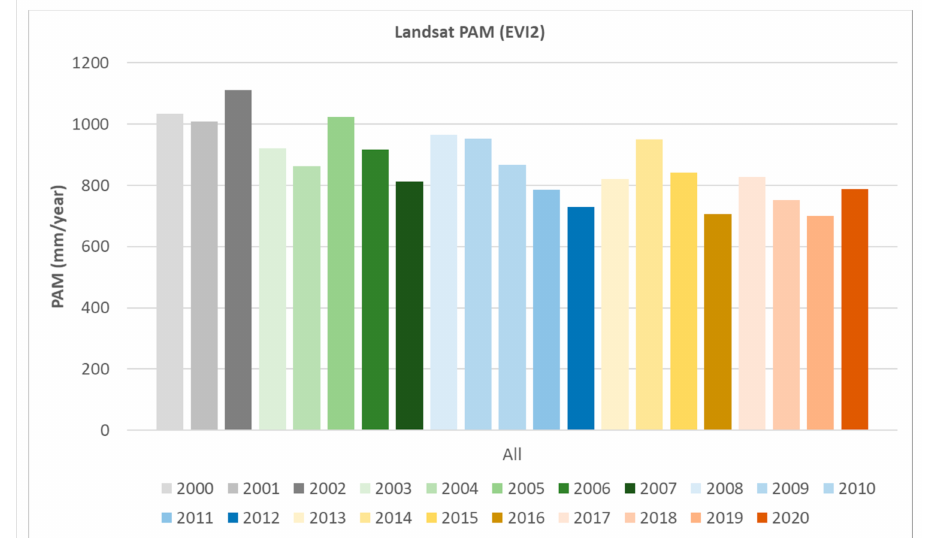
Figure 10. PAM ET (mmyr − 1 ) is shown for each of the years 2000–2020 for five reaches and the weighted average of All reaches along the Lower Colorado